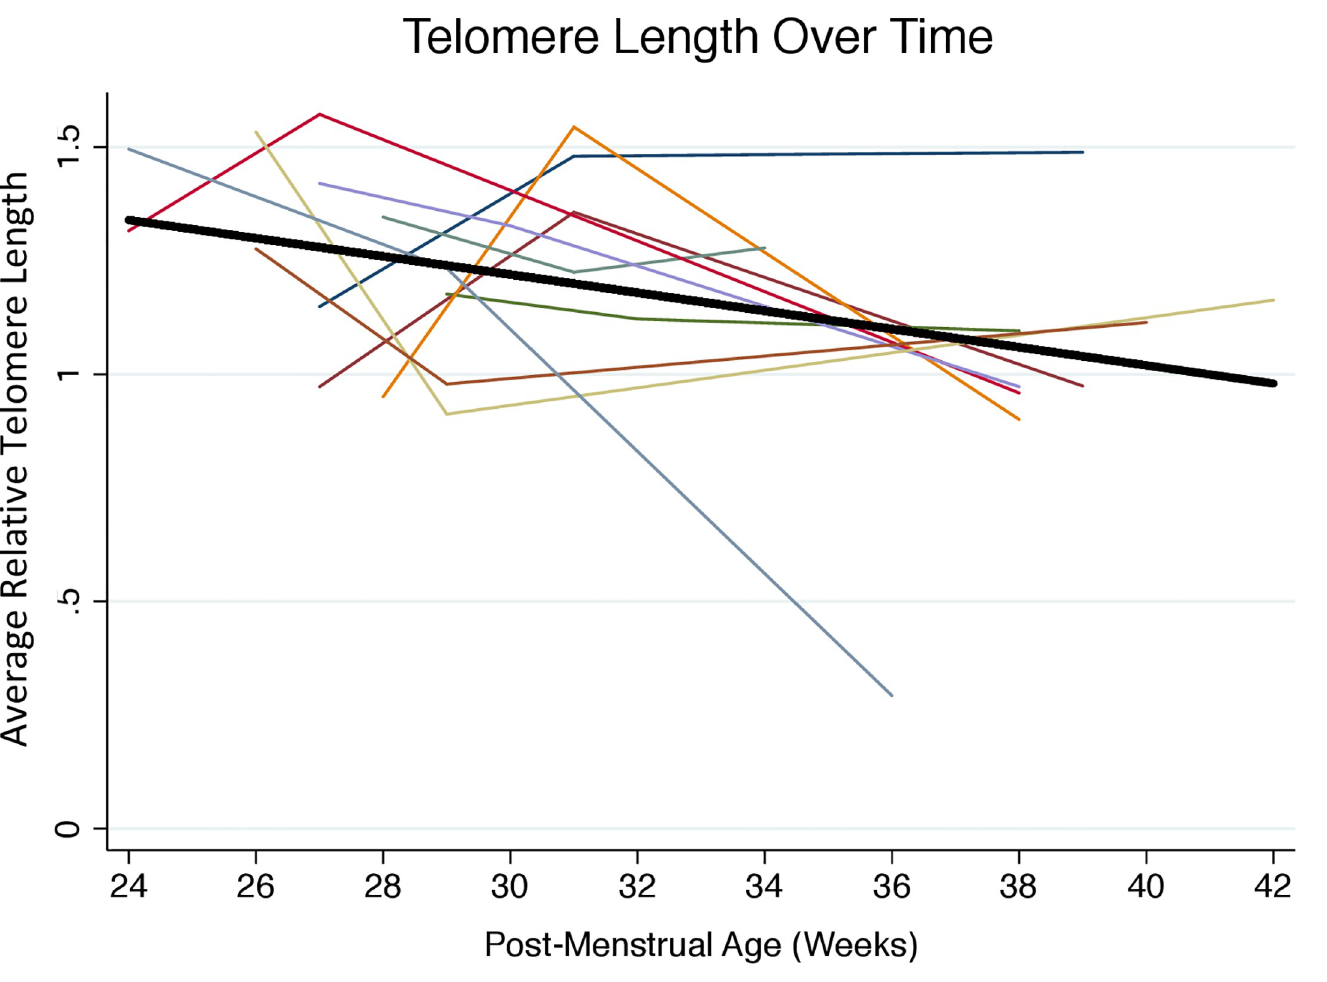
Fig 1. Change in relative telomere length with advancing postmenstrual age from birth to NICU discharge (n = 10, 3 measurements per participant). Relative telomere length was measured in triplicate by Real Time Quantitative PCR using DNA isolated from dried blood spots. Each participant is represented by a different color. The average decline in telomere length with advancing postmenstrual age and adjusted for gestational age at birth is represented by the solid black line, which has a slope of -0.02 units per week (95% CI -0.040, -0.0020; p = 0.03).